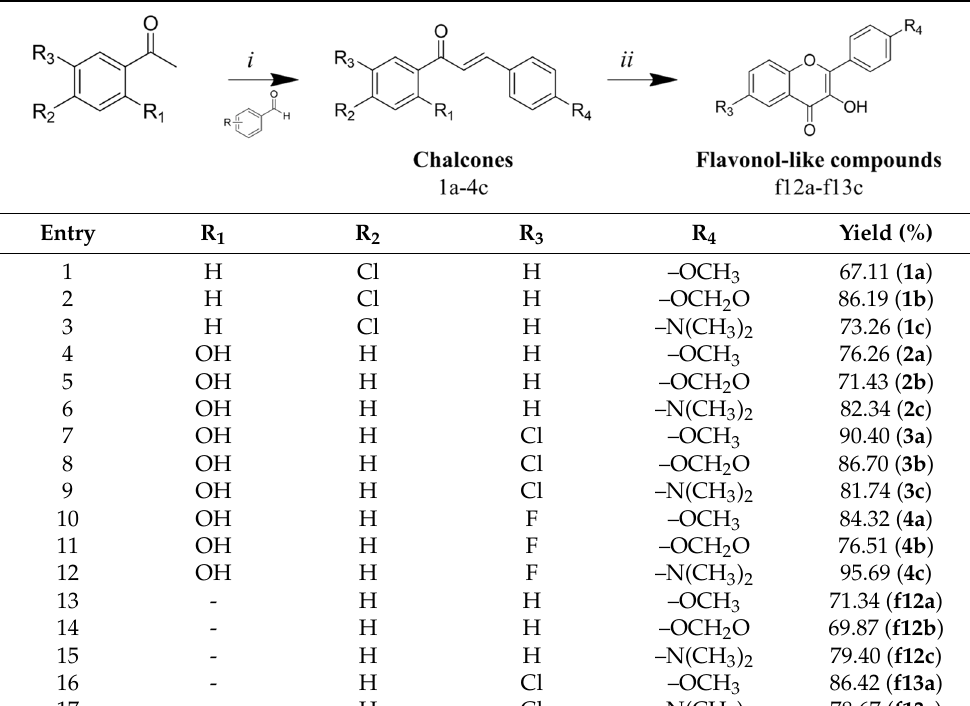
(SAR). Among acetophenones, we also used halogenated o -